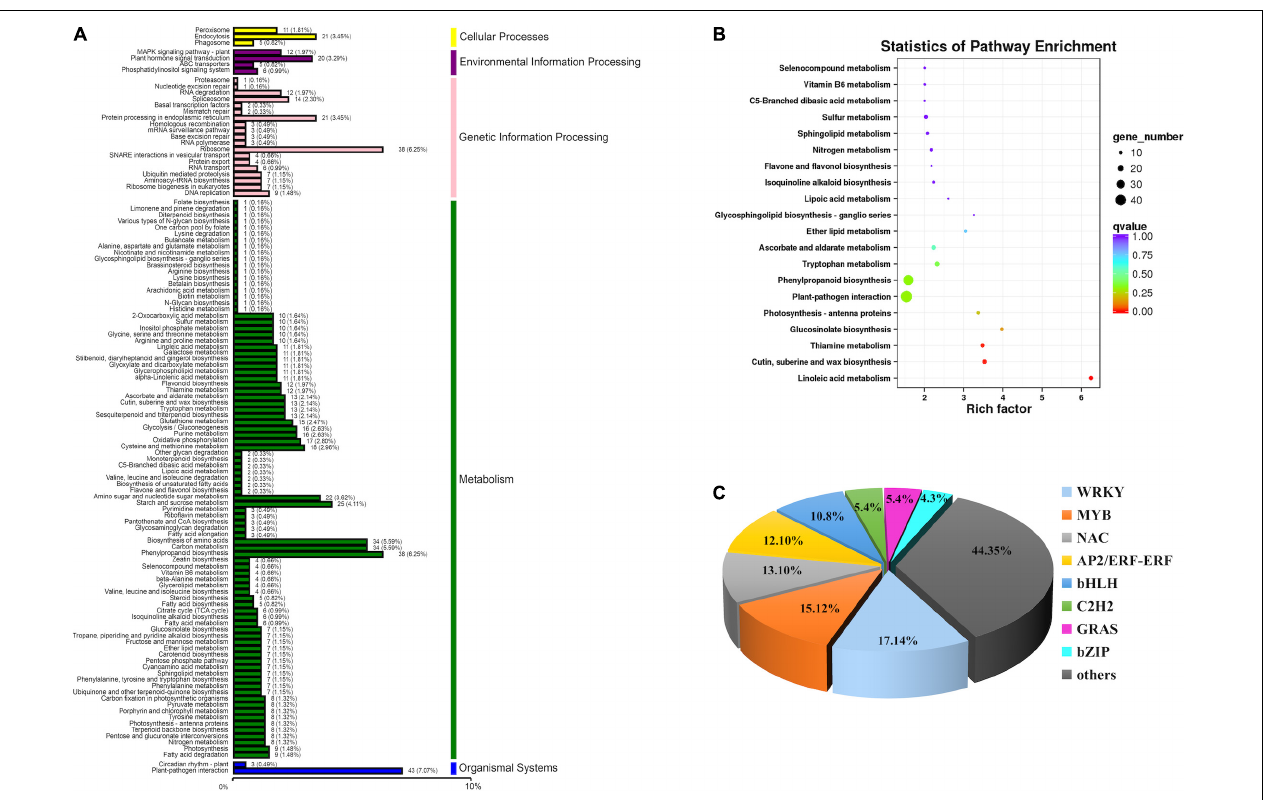
FIGURE 4 | Function annotation of DEGs. (A) Classification statistics of Kyoto Encyclopedia of Genes and Genomes (KEGG) pathway annotation. (B) The KEGG enrichment analysis of DEGs. (C) DEGs involved in transcription factors.